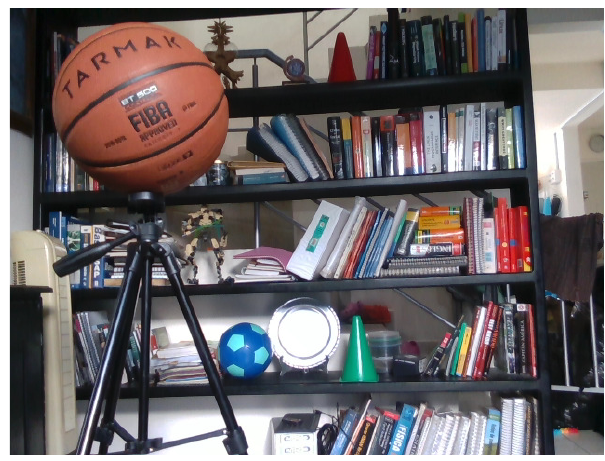
Figure 10. Scene experiment